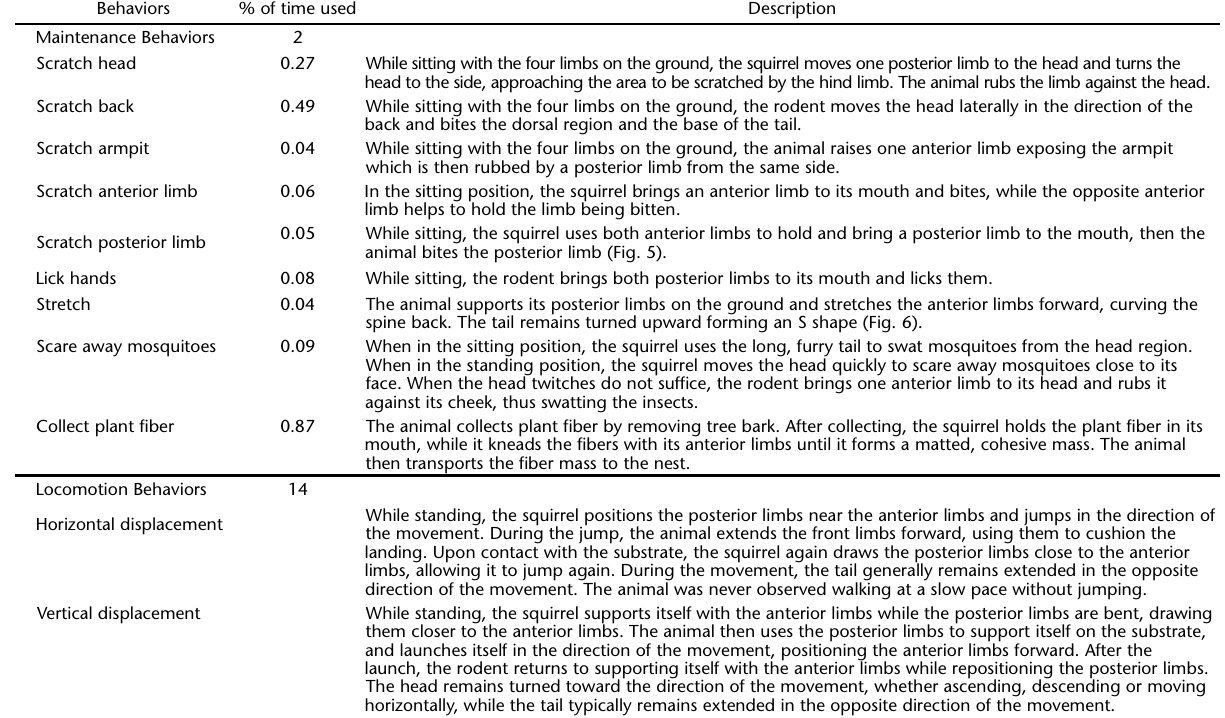
Table II. Ethogram containing the descriptions of the behaviors observed for the squirrel Guerlinguetus ingrami . Behaviors % of time used Description Maintenance Behaviors 2 Scratch head 0.27 Scratch back Scratch armpit Scratch anterior